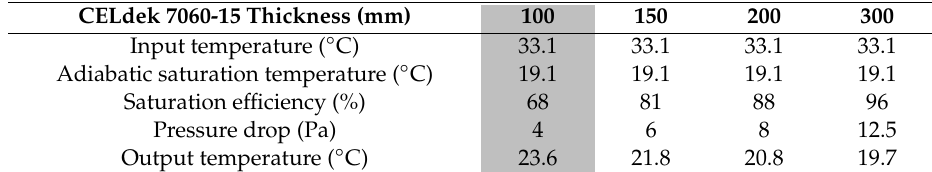
Figure 4. Evaporative cooling pad CELdek 7060-15. Table 2. Characteristics of the installed evaporative cooling pad, the selected cooling pad is highlighted with the grey background color.